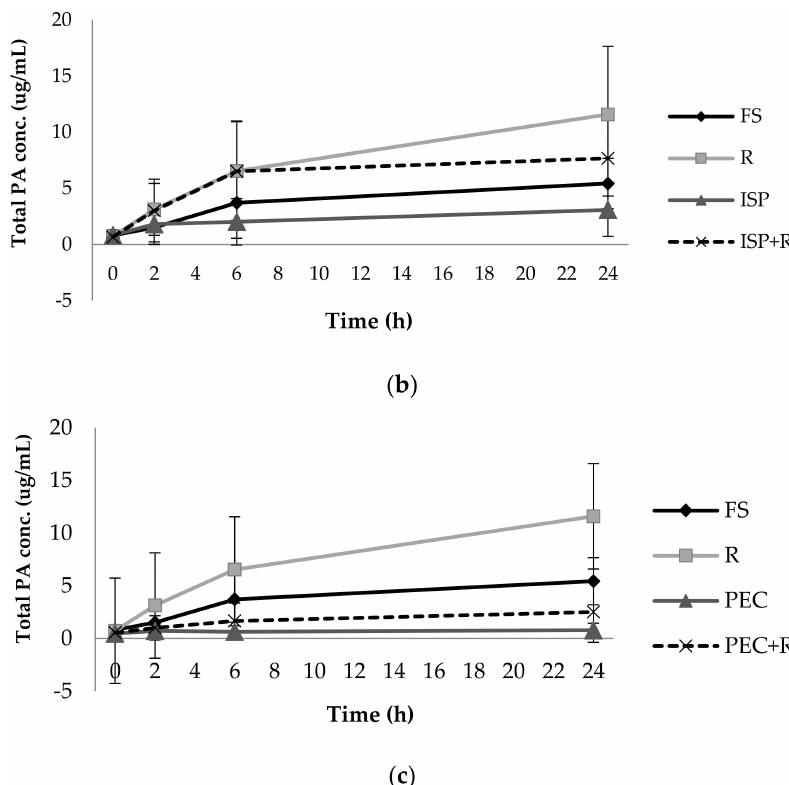
Figure 1. Impact of raftiline ( a ), ispaghula ( b ), and pectin ( c ) on total phenolic acid (PA) production from rutin incubation with human faecal bacteria. The inhibitory impact of raftiline, ispaghula, and pectin across time are demonstrated as mean ( ± SD). FS: Faecal slurry, R: Rutin, RAF: Raftiline, RR: Raftiline + Rutin, ISP: Ispaghulla, ISP+R: Ispaghula + Rutin, Pec: Pectin, PEC+R: Pectin + Rutin. Rutin and FS only incubations were matched for all groups.